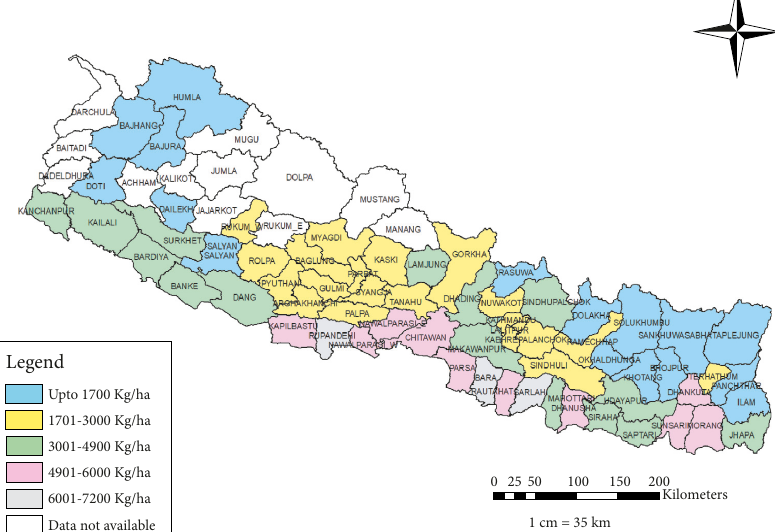
Figure 6: District-wise fish yield in Kg/ha in the fiscal year 2020/21 in Nepal, data obtained from [27]. The shapefile of Nepal required for Arc GIS was obtained from